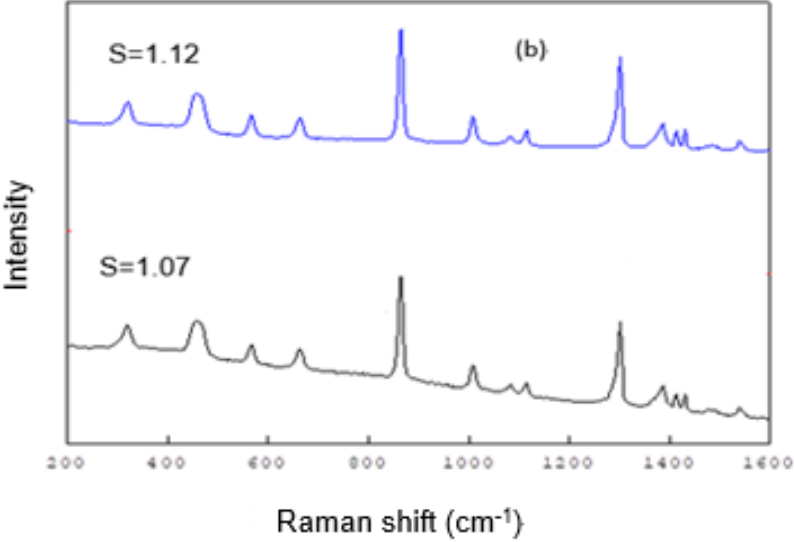
Figure 2. The Raman spectra of the produced L -glycine crystals at S = 1.07 and S = 1.12 for ( a ) C im = 0 and ( b ) C im = 10 kg/m 3 , respectively.